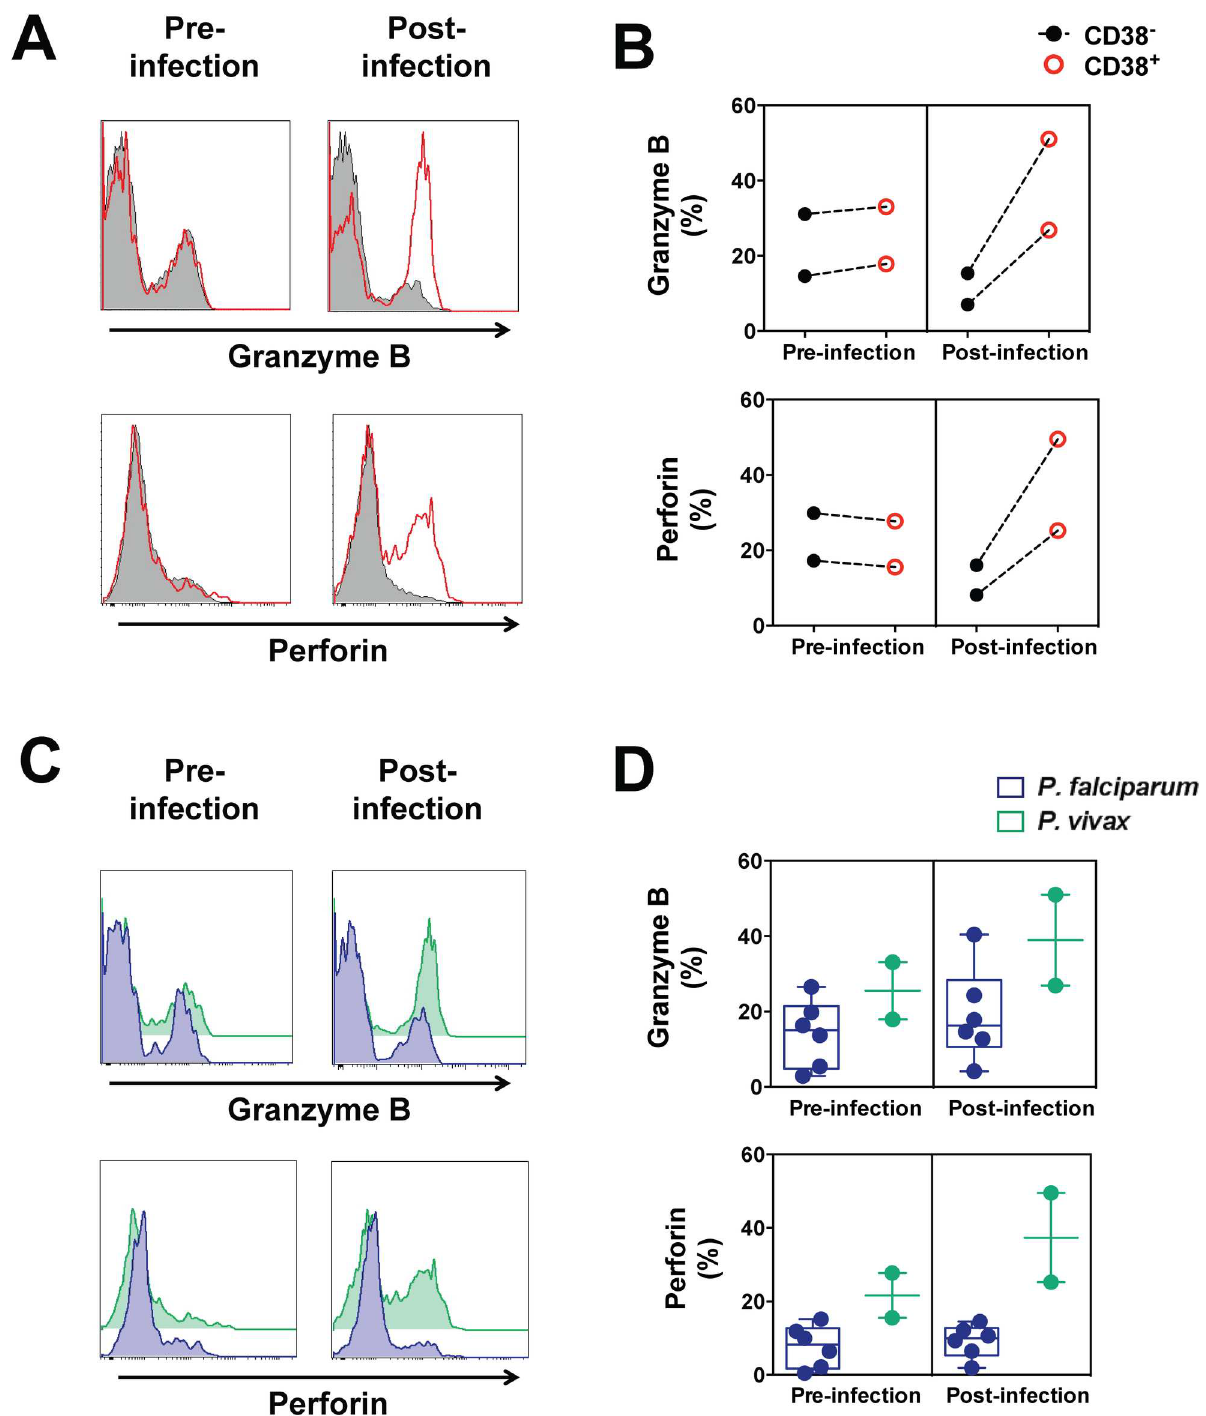
Fig 3. Granzyme B and perforin expression in circulating CD38 + CD8 + T cells following P . vivax blood-stage infection. Blood sampleswere collectedfrom malaria-naive volunteers prior to and post-infection with P . falciparum or P . vivax infected erythrocytes, as describedin legendto Fig 1. The expressionof granzymeB and perforin within CD38 + CD8 + T cells and CD38 - CD8 + T cells was determined by flow cytometry. (A) Representative stainingof granzymeB and perforin in CD38 + and CD38 - CD8 + T cells from one P . vivax infected volunteer. (B) The frequencyof cells expressinggranzyme B and perforin in CD38 + or CD38 - CD8 + T cells circulating pre- and post-infection with P . vivax . (C) Representative stainingof granzymeB and perforin in circulating CD38 + CD8 + T cells from one P . falciparum infected volunteerand one P . vivax infected volunteer. (D) The frequency of cells expressinggranzymeB and perforin in